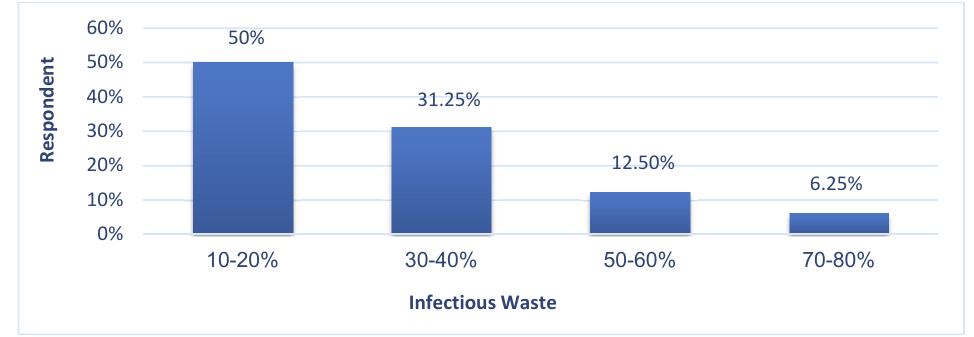
Fig. 2. Infectious waste among total Waste